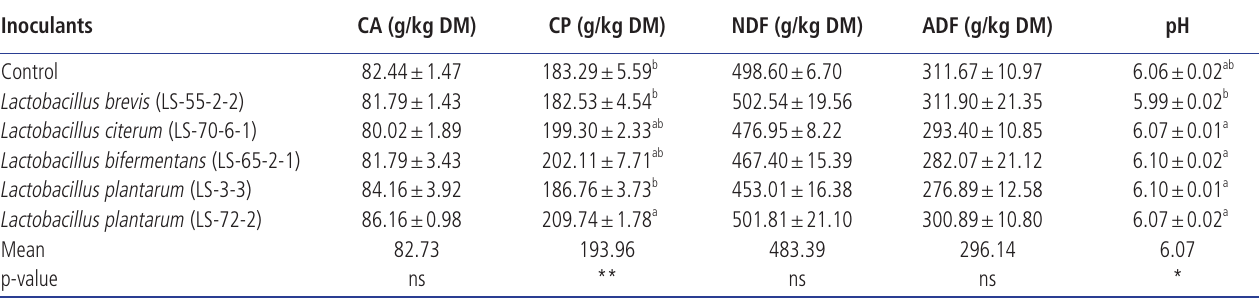
Table 1. The chemical compositions of each treatment sample of the alfalfa used as the silage material at the time T0